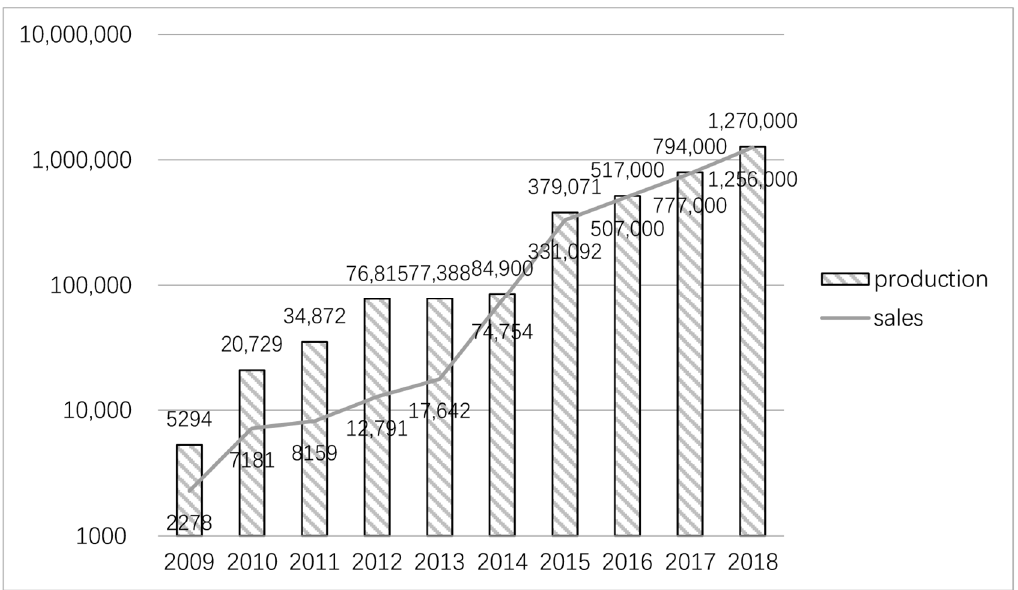
Figure 1. Production and marketing of new energy vehicles in China from 2009 to 2018.